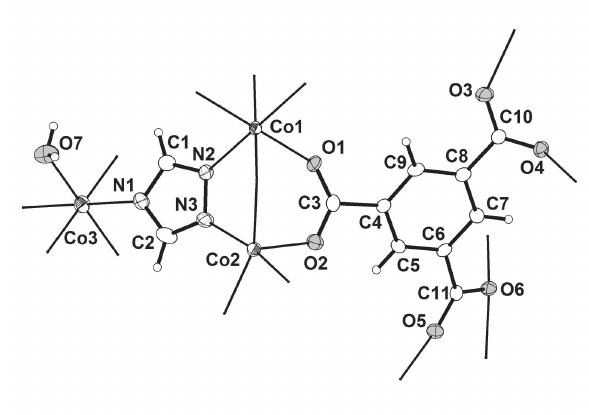
Table 1: Data collection and